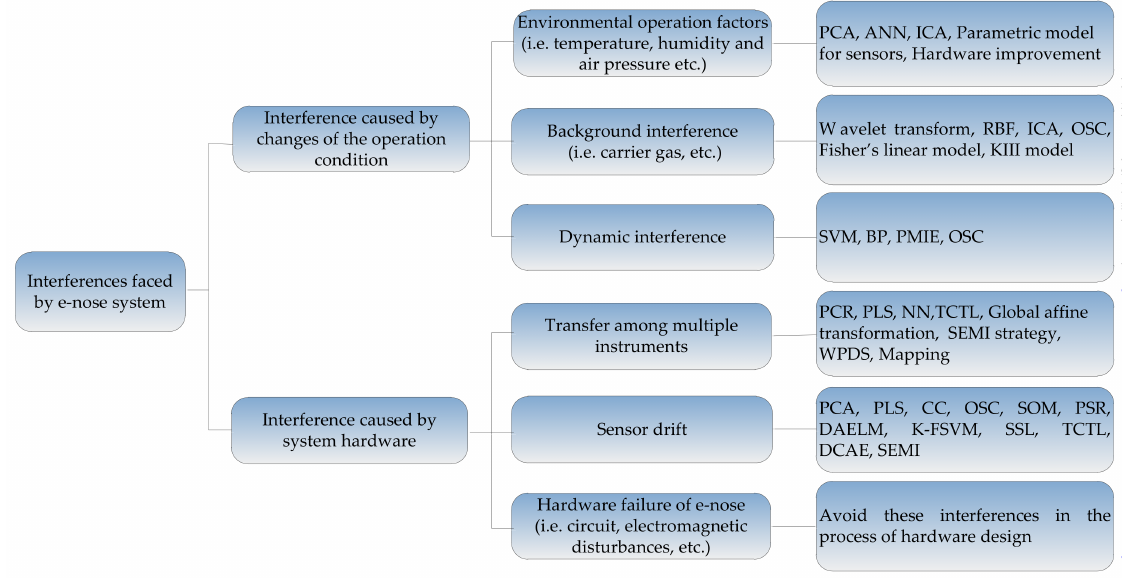
Figure 1. Types of interference and corresponding suppression